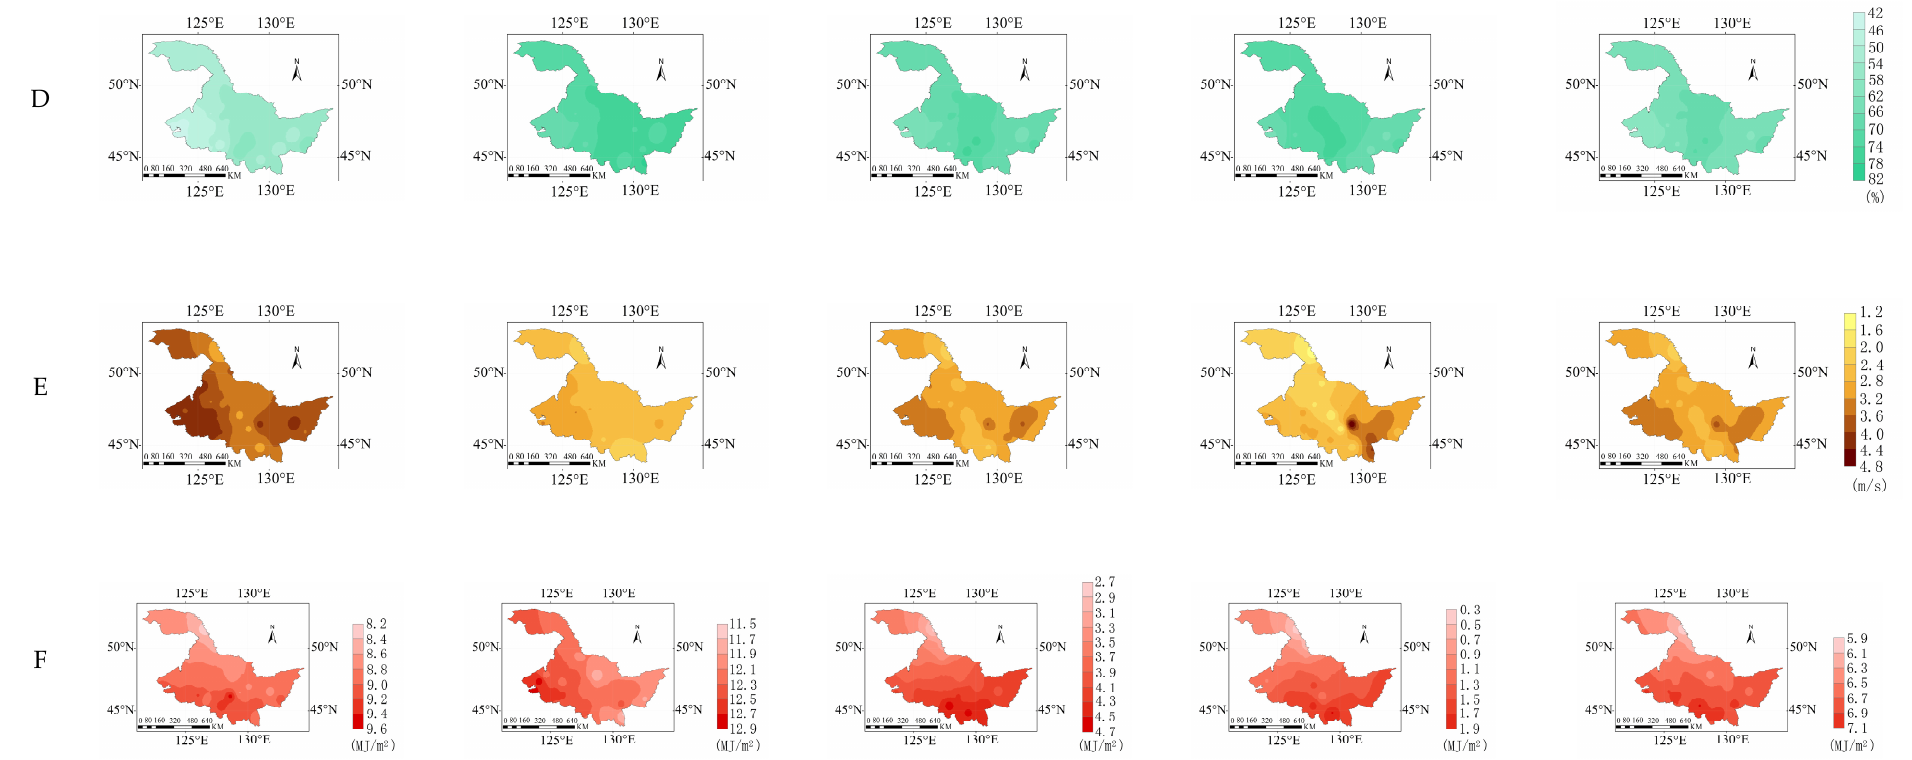
Figure 2. Spatial distribution of average ( Row A ) T max , ( Row B ) T min , ( Row C ) T mean , ( Row D ) RH , ( Row E ) U , ( Row F ) Rn from 1960 to 2019.